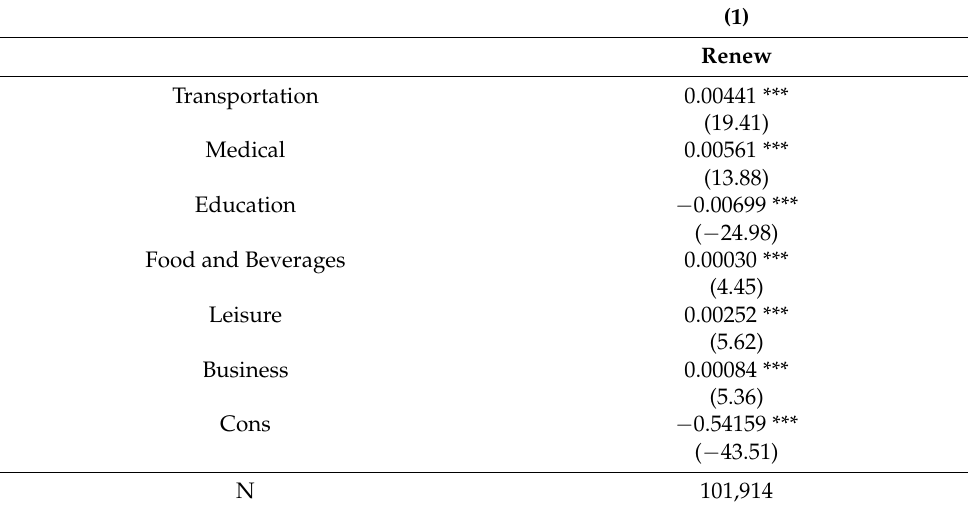
Table 2. Results of Logit regression.